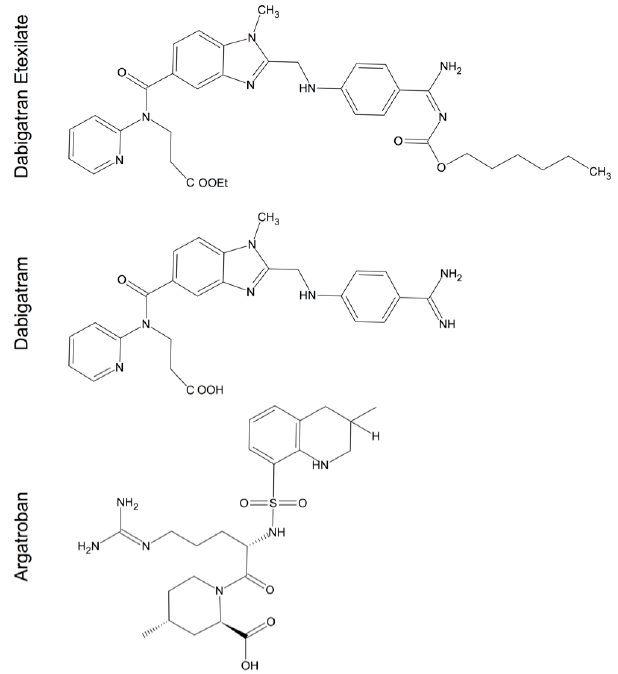
Figure 5. 2D chemical structure of common direct acting thrombin inhibitors (DIT). The given structures depict the low molecular weight DTIs: the prodrug dabigatran etexilate, the active principle dabigatran and argatroban [158,159].